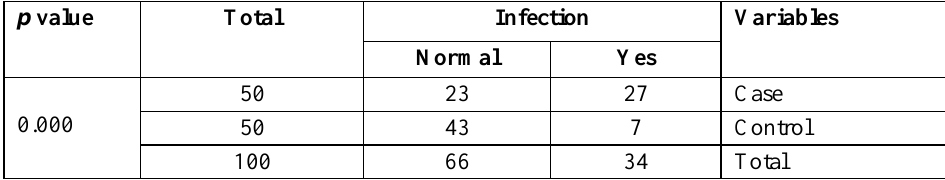
Table 4. Frequency of infection among studied groups.